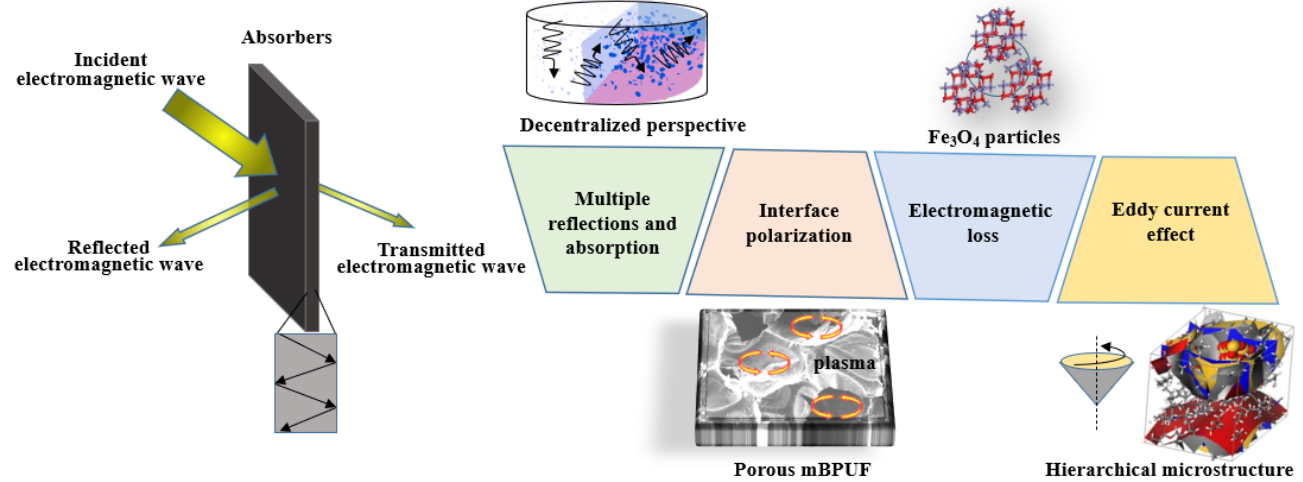
Figure 7. Schematic illustration representing the microwave absorption mechanism for the mBPUF composite.